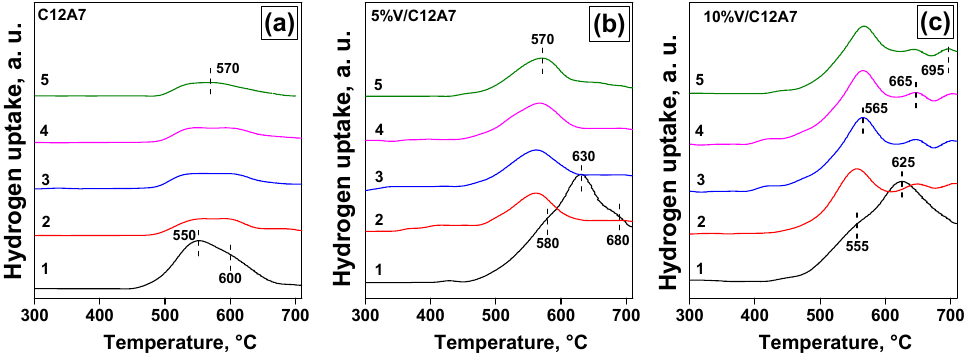
Figure 8. TPR-H 2 profiles for the studied samples: ( a ) C12A7; ( b ) 5%V/C12A7; ( c ) 10%V/C12A7. The number of redox cycles is written above each curve. Table 2. Hydrogen uptake in TPR-H 2 experiments for pure mayenite and vanadia-mayenite composites. Number of Redox